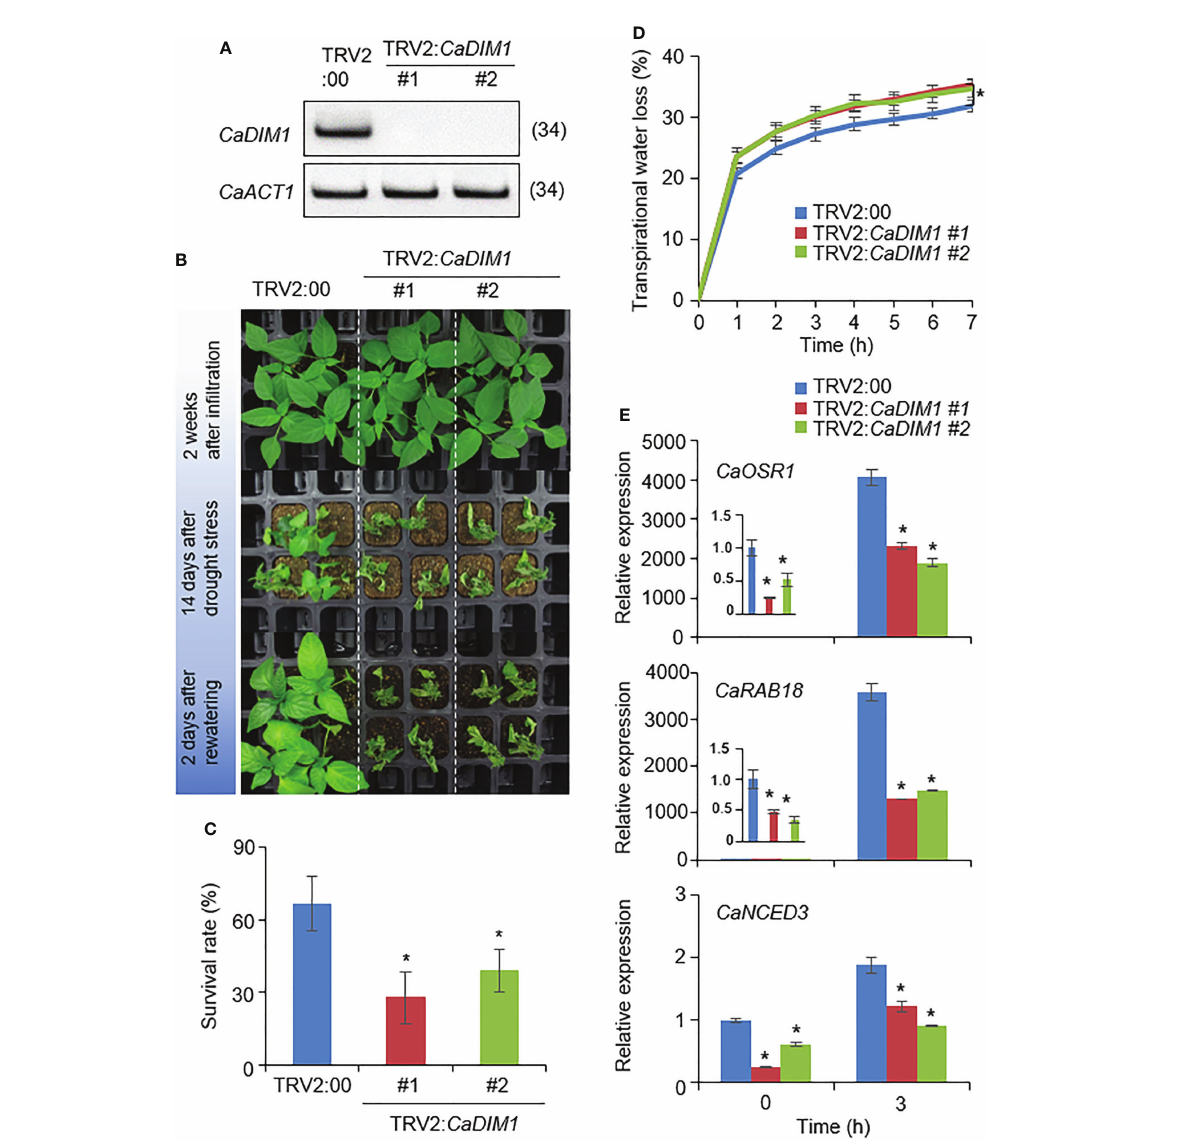
FIGURE 2 Reduced tolerance of CaDIM1 -silenced pepper plants to drought stress. (A) RT-PCR assay of CaDIM1 expression in CaDIM1 -silenced pepper plants and control plants (TRV2:00). The pepper Actin1 ( CaACT1 ) gene was used as an internal control. (B) Drought sensitivity of control (TRV2:00) and CaDIM1 -silenced pepper (TRV2: CaDIM1 ) plants. Four-week-old plants of each line were re-watered for 2 days after drought stress was imposed for 14 days by withholding watering. Representative images were taken before (top) and after (middle) drought, as well as after 2 days of re-watering (bottom). (C) Survival rates of TRV2:00 and TRV2: CaDIM1 pepper plants after 2 days of re-watering. Data represent the mean ± standard error of three independent experiments; in each of these experiments, 20 plants were evaluated. (D) Transpirational water loss from the leaves of TRV2:00 and TRV2: CaDIM1 plants. Leaves from plants of each line were detached, and the fresh weights of leaves were measured every hour for 7 h. Data represent the mean ± standard error of three independent experiments; in each of these experiments, 10 plants were evaluated. (E) Quantitative real-time polymerase chain reaction analysis of stress-responsive genes in the leaves of CaDIM1 -silenced pepper plants (TRV2: CaDIM1 ) and control plants (TRV2:00). Control and CaDIM1 -silenced pepper plants were subjected to dehydration for 3 h after detachment. The relative expression levels ( DD CT) of each gene were normalized to the geometric mean of the pepper Actin1 (CaACT1 ) gene, which was used as an internal control. Asterisks indicate signi fi cant differences between TRV2:00 and TRV2: CaDIM1 plants (Student ’ s t - test; * P <